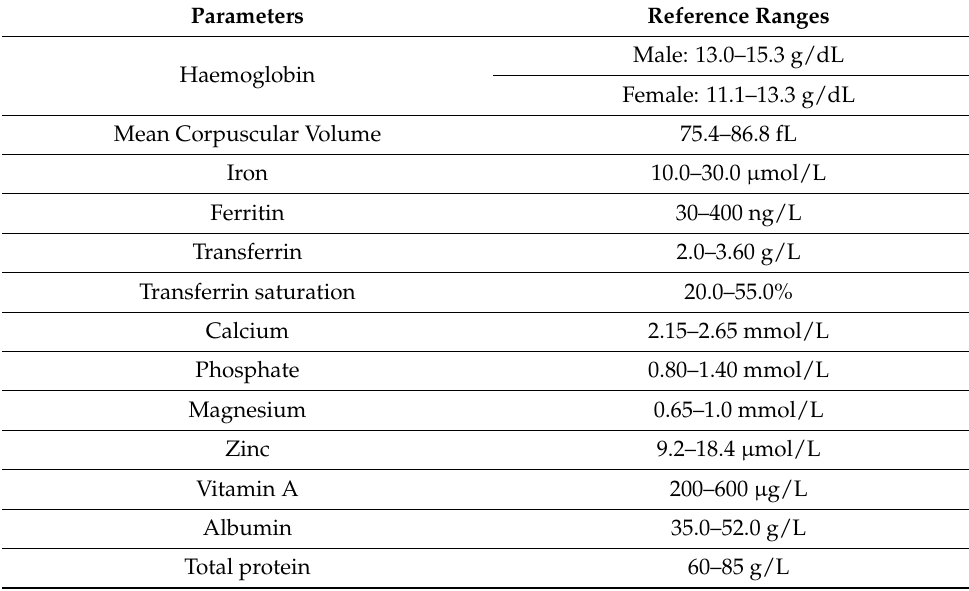
Table 1. Blood analytes and laboratory reference